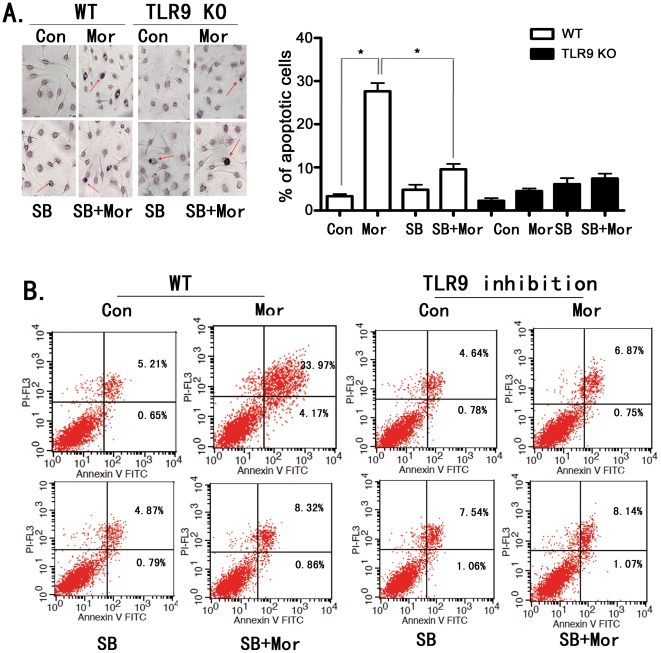
Inhibition of p38 MAPK by SB203580 attenuates morphine-induced
microglia apoptosis.WT microglial cells and TLR9 deficient microglial cells were pretreated
with 10 µM SB203580 (SB) for 1 hr and then exposed to morphine at
10 µM for 24 hr. Apoptotic cells were determined as in Fig. 3. (A).
Representative light microscopic images showed TUNEL-positive microglia
(red arrow head). Magnification 200×. Results represent mean
± SD from three independent experiments. *
p<0.01 compared with indicated groups. (B).
Apoptotic cells were analyzed by flow cytometry. Three experiments were
performed with similar results.